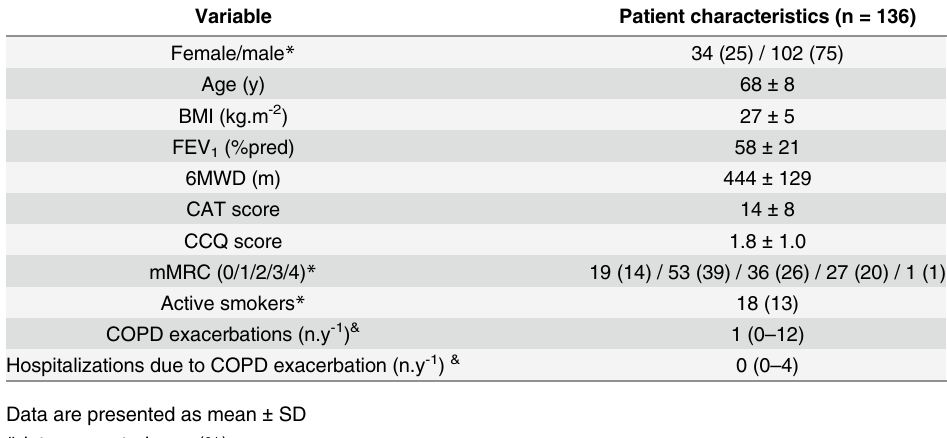
Table 1. Patient